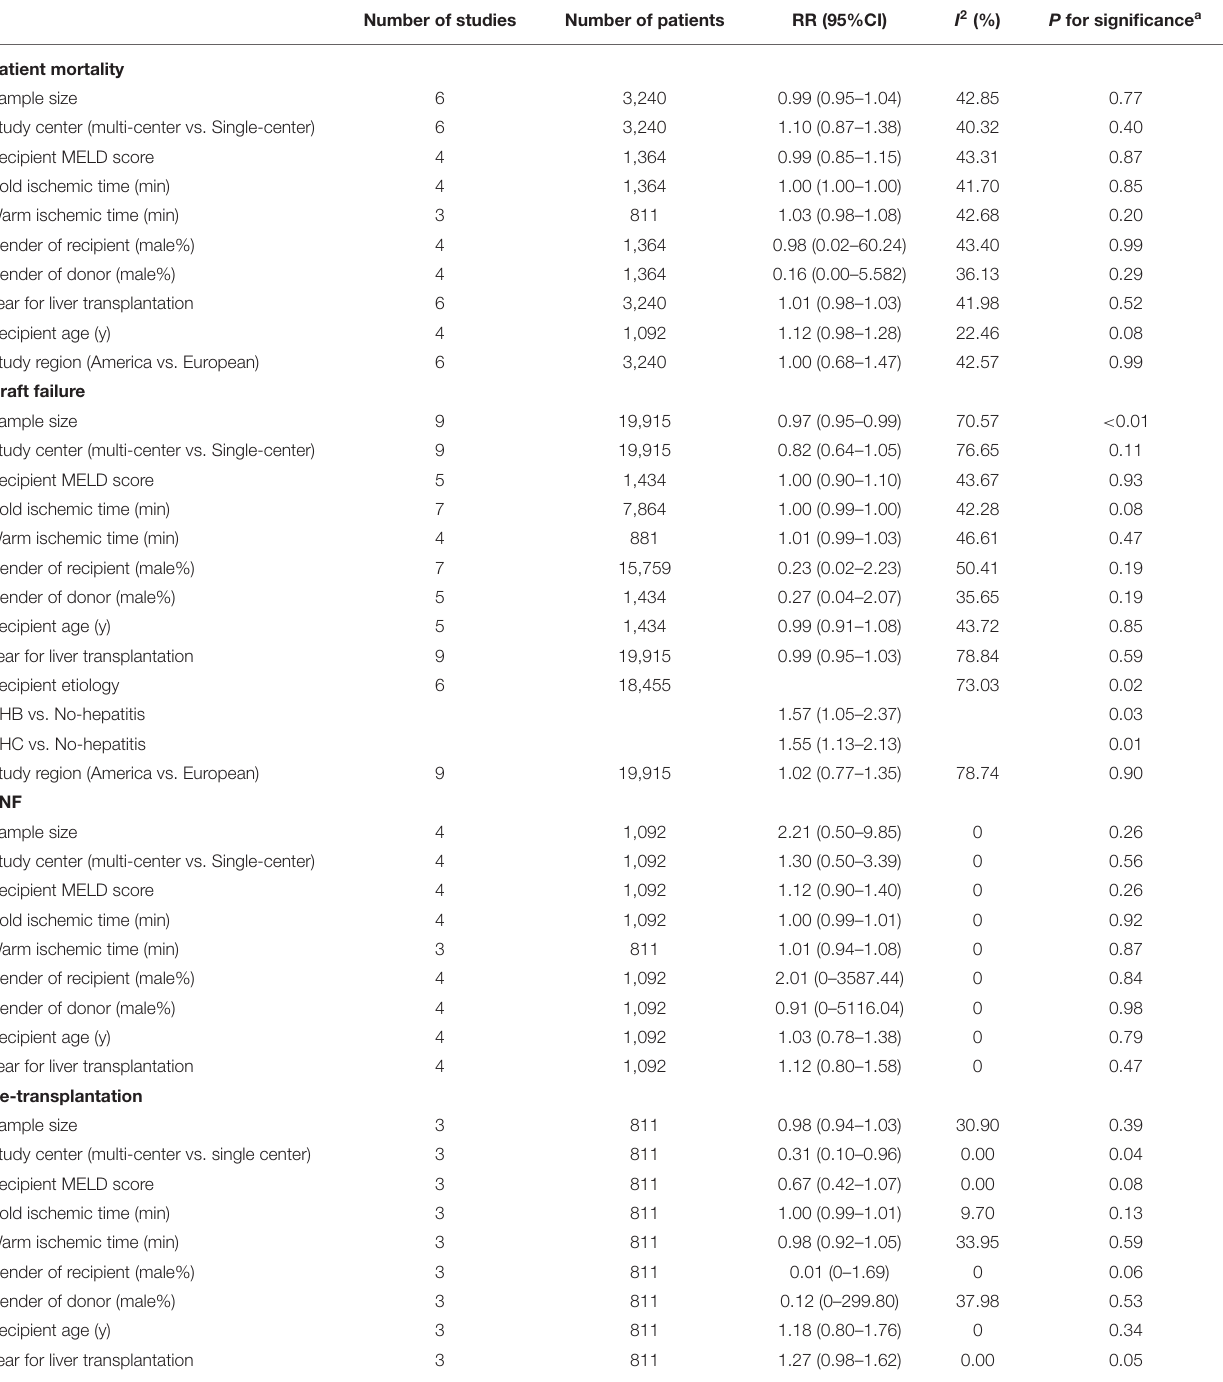
TABLE 6 | Meta regression on donor age related risk of post-transplant outcomes in dose response model. Number of studies Number of patients RR (95%CI) I 2 (%) P for significance